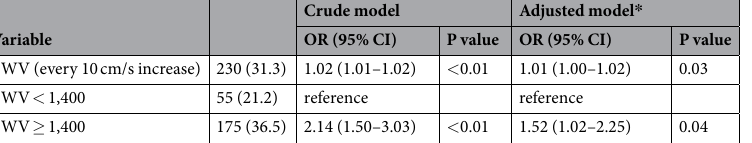
Table 2. Different risk classifications in the prediction of new carotid plaque formation * Adjusted for age,